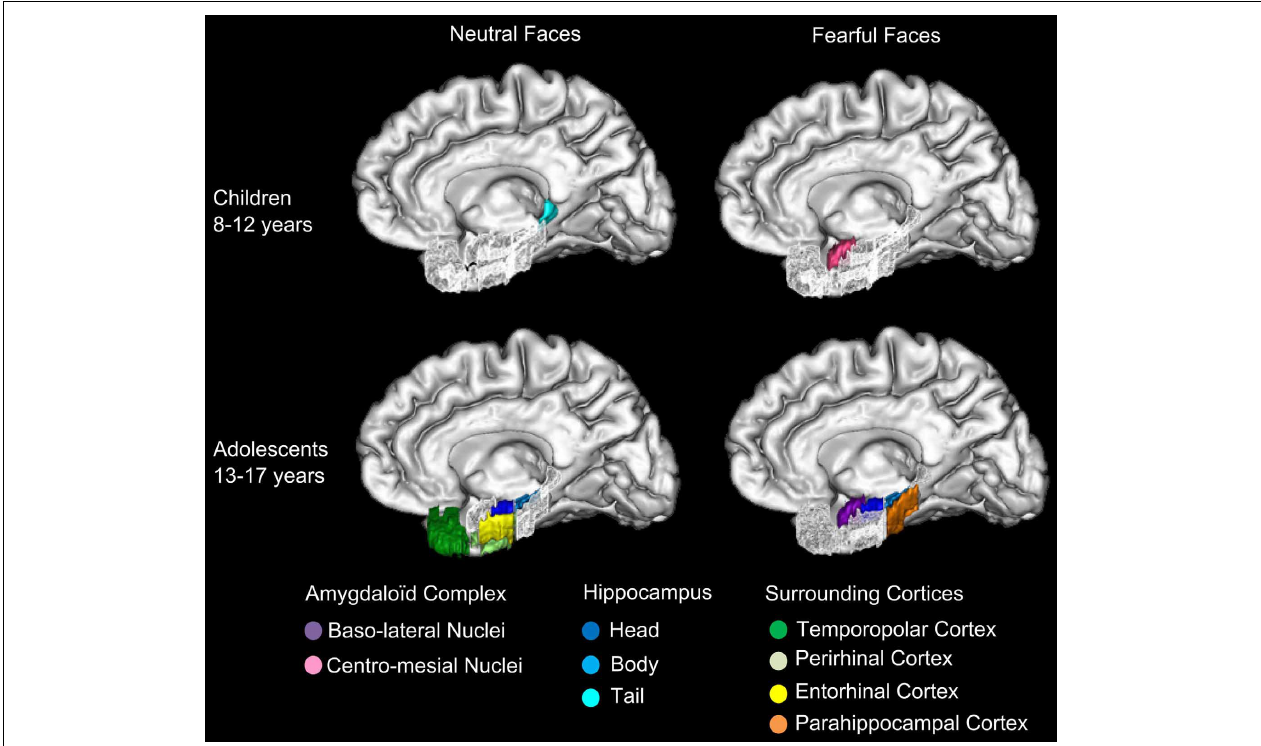
FIGURE 6 | Specializations of amygdaloid complex nuclei and MTL for neutral and fearful faces across groups. The specialized activations of baso-lateral amygdaloid nuclei (AC) and medial temporal lobe (MTL) memory network are schematized in this figure. In 8–12 years children, centro-mesial amygdaloid complex nuclei are activated for successful encoding of both neutral and fearful faces and hippocampal tail is activated for successful encoding of neutral faces. In 13–17 years adolescents, successful encoding of